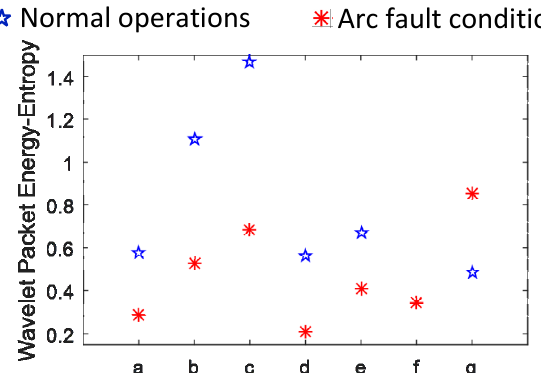
Figure 11. The percent of the energy of Cj in the whole signal energy of different load types during normal operations and serial arc fault conditions (Y axis indicates the percent of the energy of Cj in the whole signal energy). (a) Induction cooker. (b) Incandescent lamp. (c) Hairdryer. (d) Notebook computer. (e) Electric drill. (f) Electric oven. (g) Vacuum cleaner